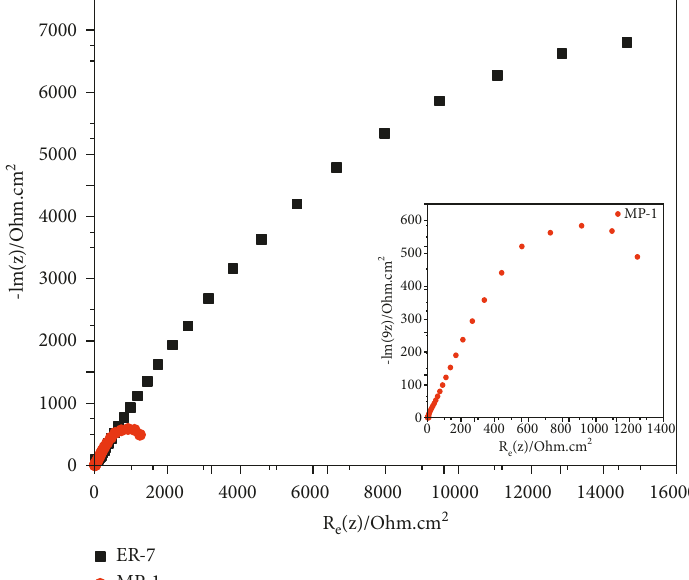
Figure 9: The EIS spectrum of mechanically polished and electropolished SLM manufactured Ti-6Al-4V alloy in 0.5MH2SO4 at 30.0 ° C.